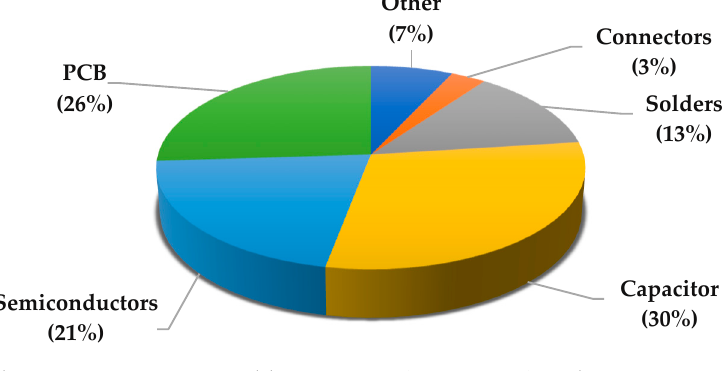
Figure 1. Distribution of failures in power devices [9].